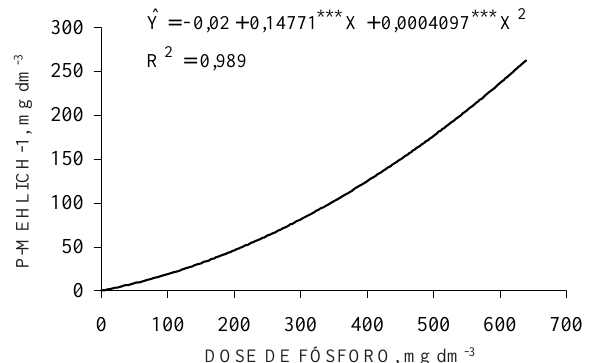
Figura 1. Variação dos teores de fósforo recuperados pelo extrator Mehlich-1, conforme as doses de fósforo aplicadas (*** significativo a